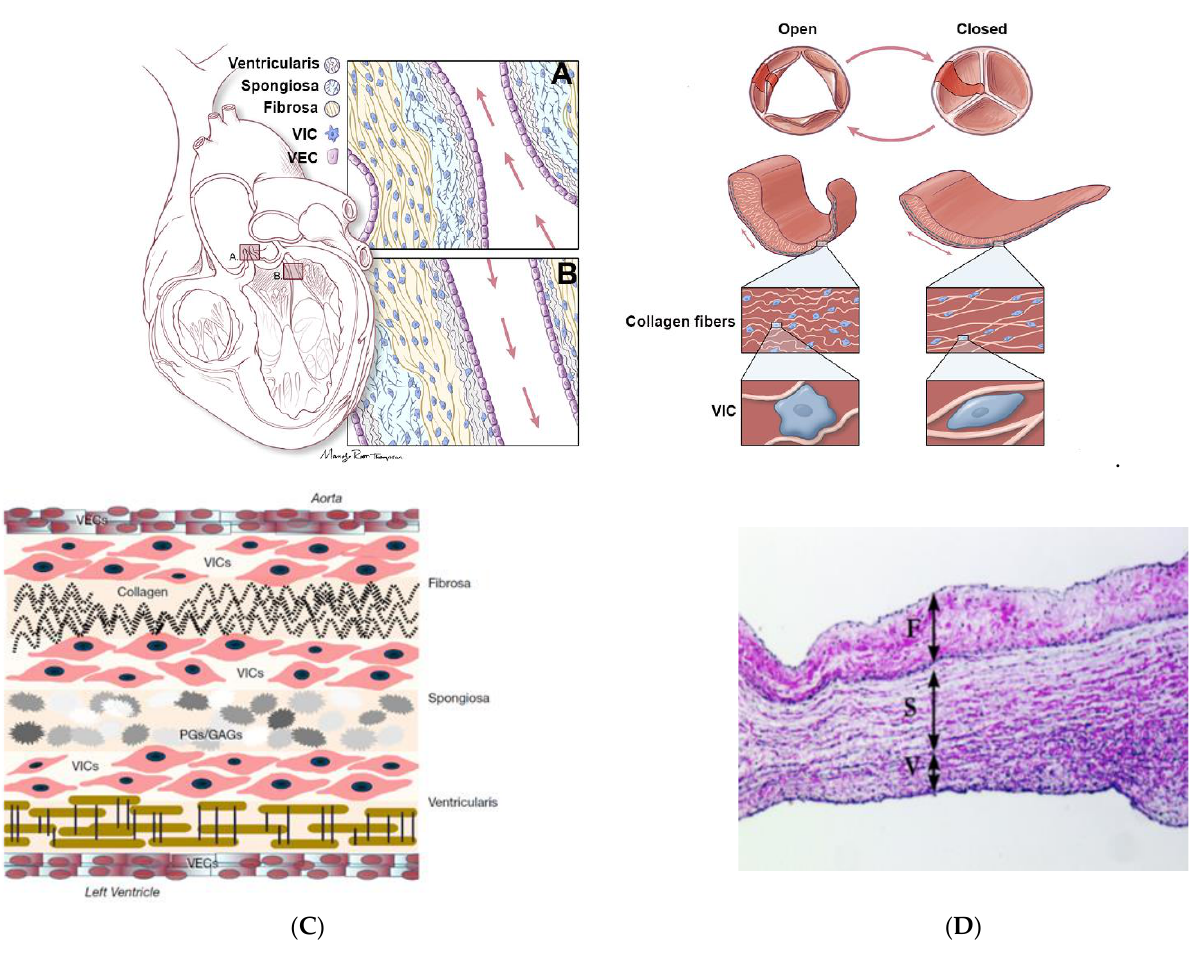
Figure 7. Representation of aortic and mitral valve structures. ( A ) Aortic valve and ( B ) mitral valve, with the three ECM layers: ventricularis (EL), spongiosa (PG-GAG) and fibrosa (COL); the blood flow is indicated by red arrows (ventricularis closest to blood flow); valve endothelial cells (VECs, purple) and valve interstitial cells (VICs, blue). (Right) Representation of the aortic valve indicating coordinated rearrangement of the ECM fibers, and elongation of the VICs during systole (open) and diastole (closed). Reprinted with permission from ref. [111]. Copyright 2020, MDPI. ( C ) Detailed heart valve structure: the three inner layers (ventricularis, spongiosa and fibrosa) with proteoglycans (PG), glycosaminoglycans (GAG), collagen type I and type III, elastin and VICs and the outer layer formed by VECs. Reprinted with permission from ref. [105]. Copyright 2015, Cambridge University Pres. ( D ) Tissue image of trilayered structure of an aortic leaflet in sheep. The three layers consist of fibrosa (F), spongiosa (S) and ventricularis (V). Reprinted with permission from ref. [112]. Copyright 2015, SciDoc